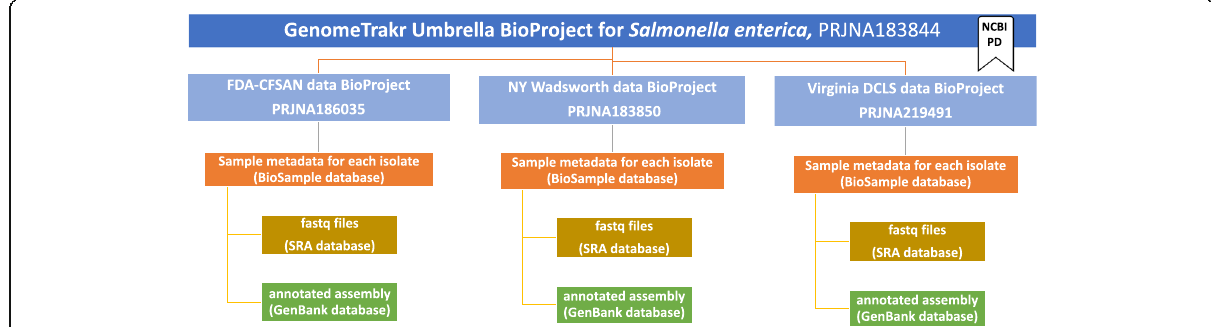
Fig. 5 Overview of the database structure at NCBI showing an example Salmonella umbrella BioProject with three linked laboratory data BioProjects, each with their own BioSamples and associated sequence